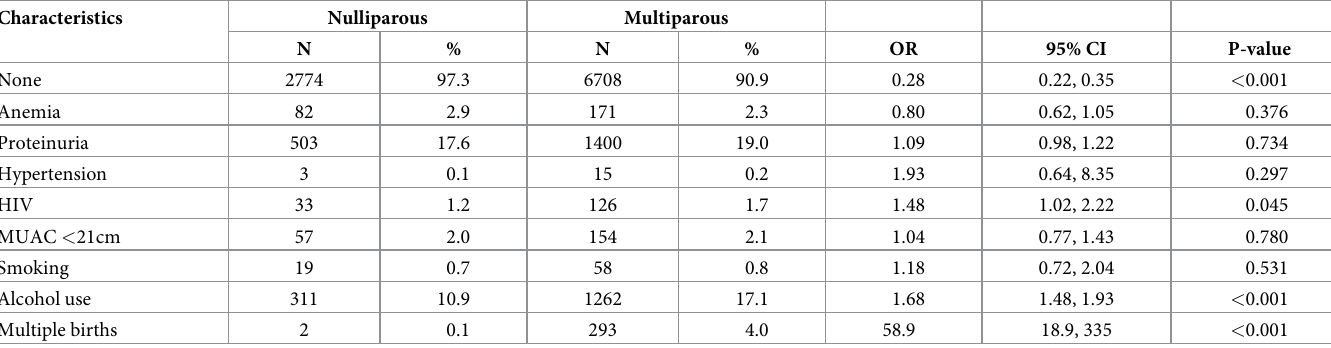
Table 5. Obstetric risk factors identified at ANC-1 associated with parity in univariate models.